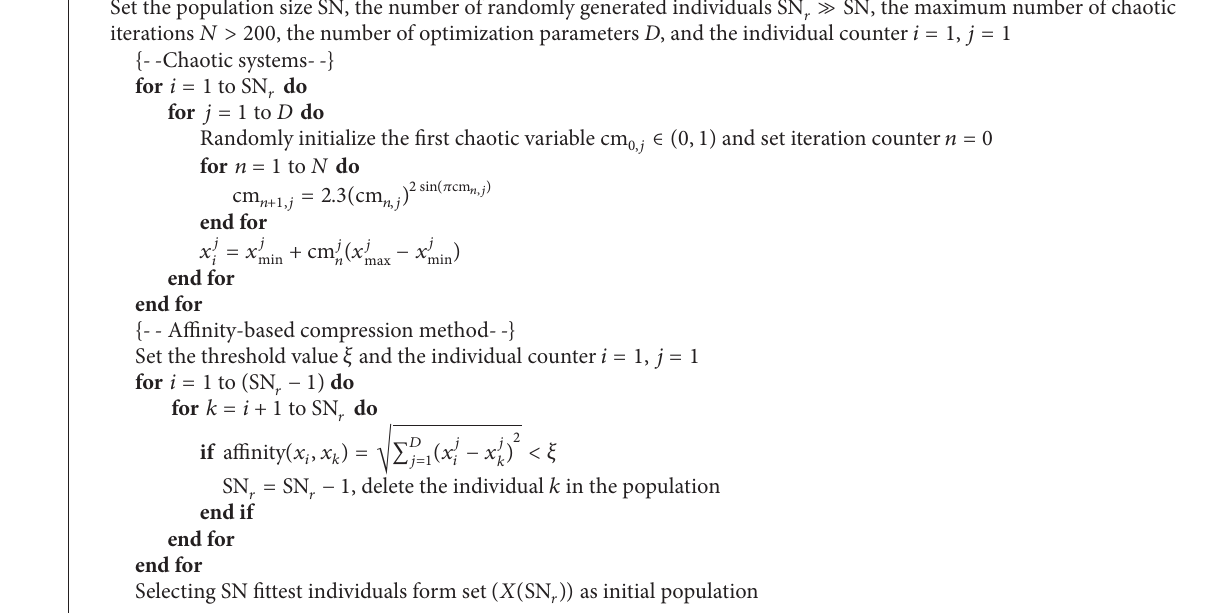
Algorithm 2: Modified initialization step of ABC